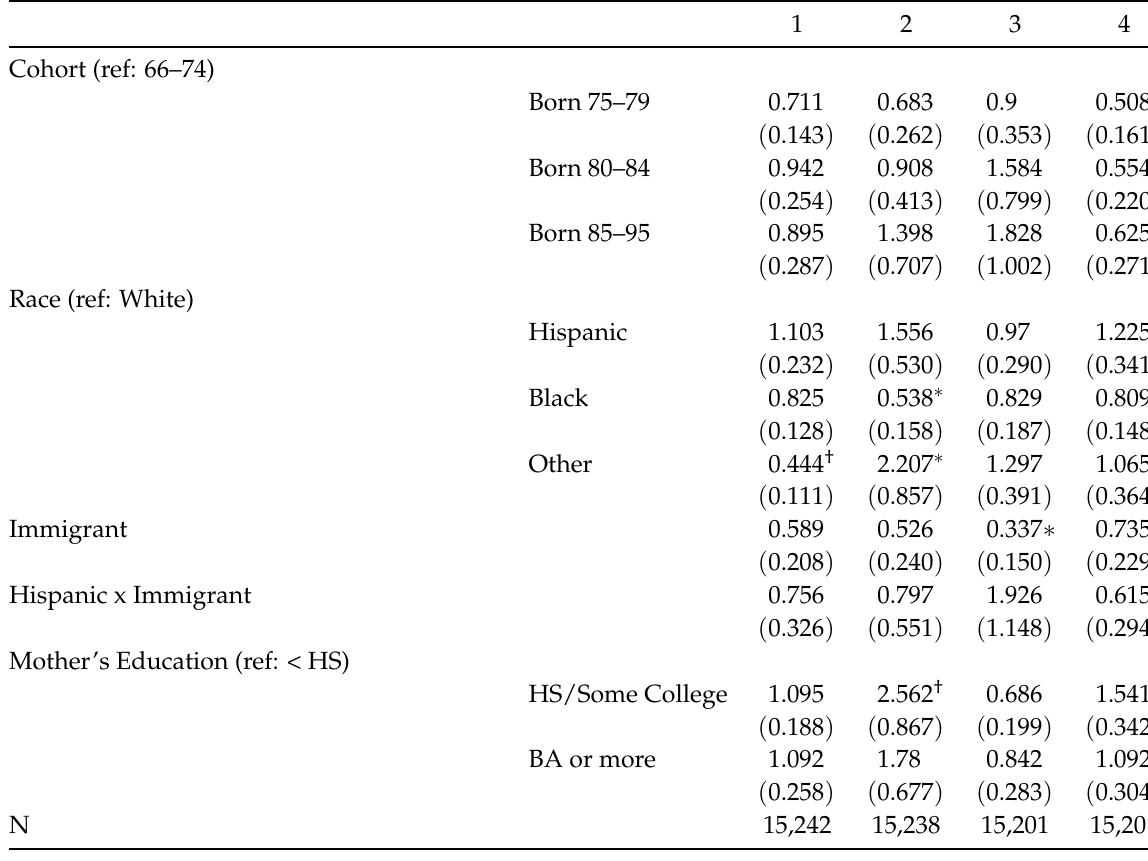
Table 4: Odds ratios from four logistic regressions predicting whether men (1) have had male and female sexual partners (ever), (2) have had only male sexual partners (ever), (3) identify as bisexual, and (4) identify as